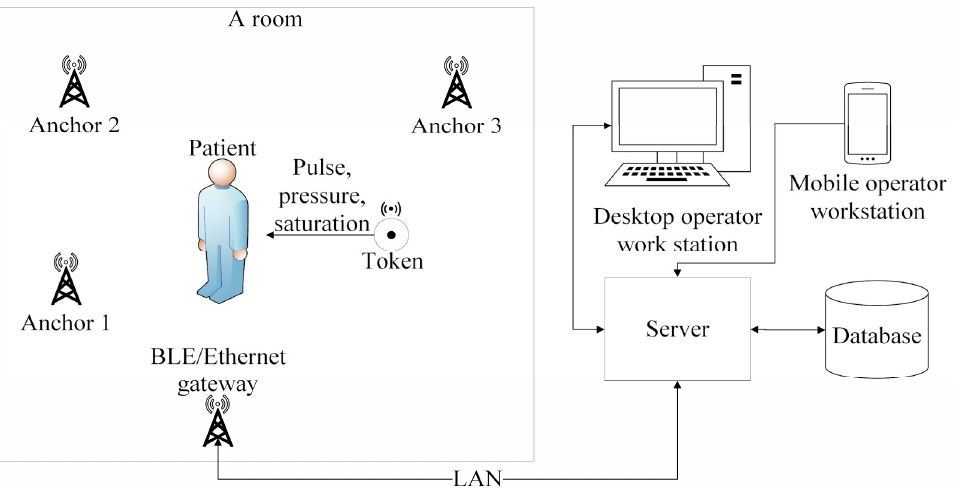
Figure 1. The architecture of the IPS.